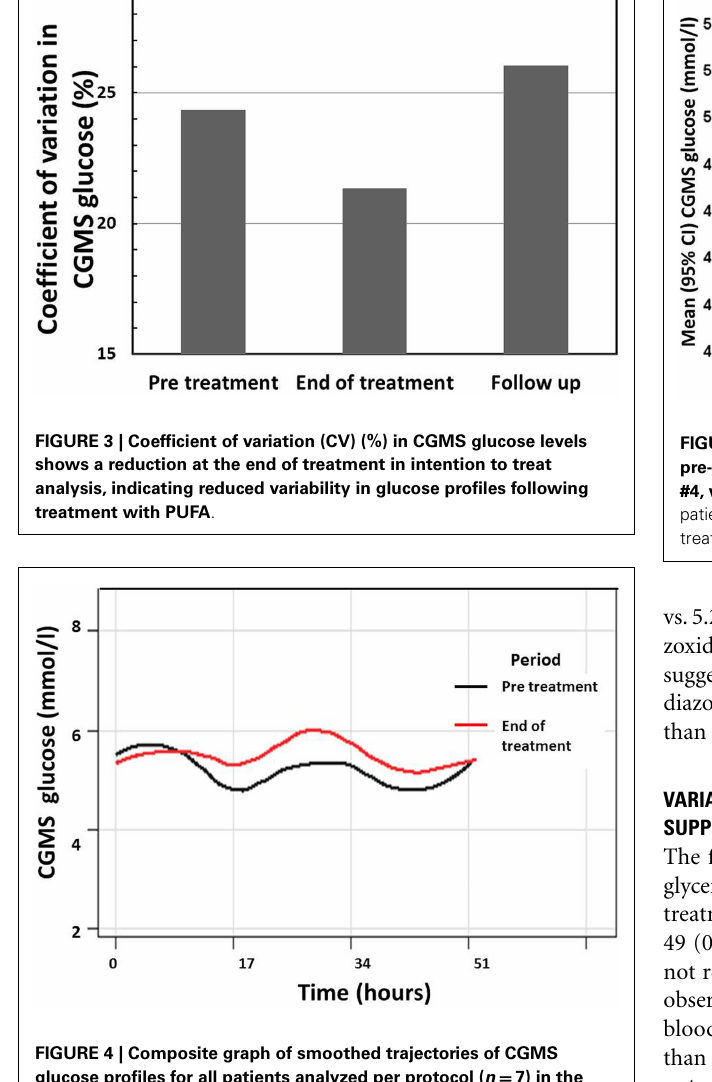
FIGURE 4 | Composite graph of smoothed trajectories of CGMS glucose profiles for all patients analyzed per protocol ( n = 7) in the pre-treatment (black line) and end of treatment (red line) periods show overall improvement in glycemic control following PUFA treatment . Individual glucose values have not been shown for clarity.